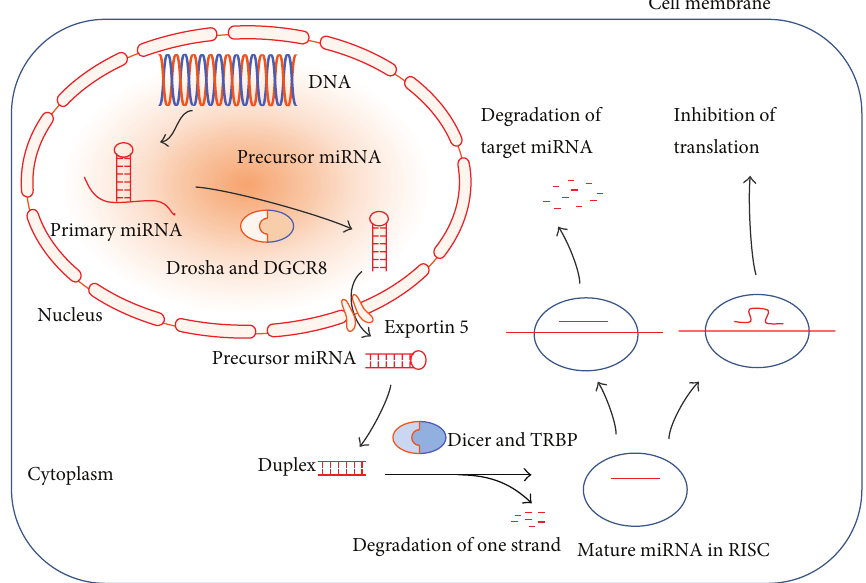
Figure 1: Biogenesis of miRNA. miRNAs are transcribed from DNA into primary-miRNAs (Pri-miRNAs) which contain hairpin-like structures. RNase III Drosha and its binding partner, DiGeorge syndrome critical region gene 8 (DGCR8), bind to the hairpin structures in Pri-miRNAs and process them into precursor miRNAs (Pre-miRNAs). Through Exportin 5, Pre-miRNAs are transferred into cytoplasm and are processed by another RNase III enzyme, Dicer, in collaboration with transactivating response RNA-binding protein (TRBP) to generate the mature miRNA duplex. One strand of the duplex goes into RNA-induced silencing complex (RISC), while the other is degraded. In RISC, mature miRNA recognizes target mRNAs through sequence complementarity, resulting in either degradation of the target mRNA (perfect complementarity to 3 󸀠 UTR) or more frequently inhibition of translation (imperfect complementarity to 3 󸀠